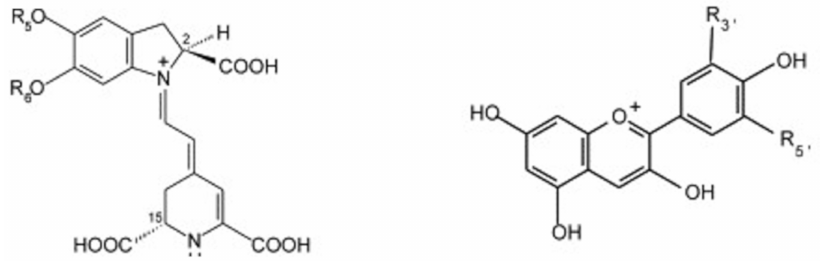
Figure 1. Typical structure of betalains ( left —betacyanin) and anthocyanins ( right